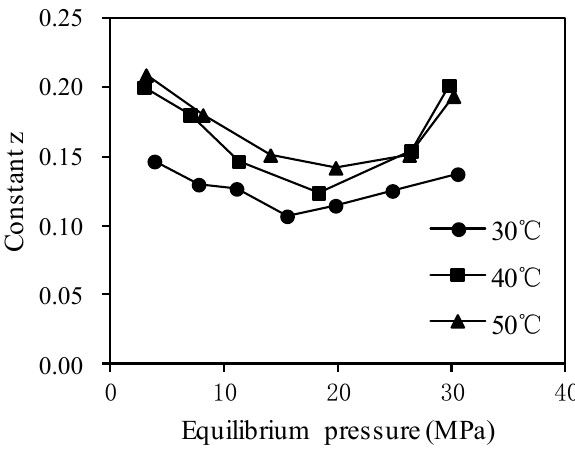
Figure 8. Constant Z versus equilibrium pressure at different temperature.